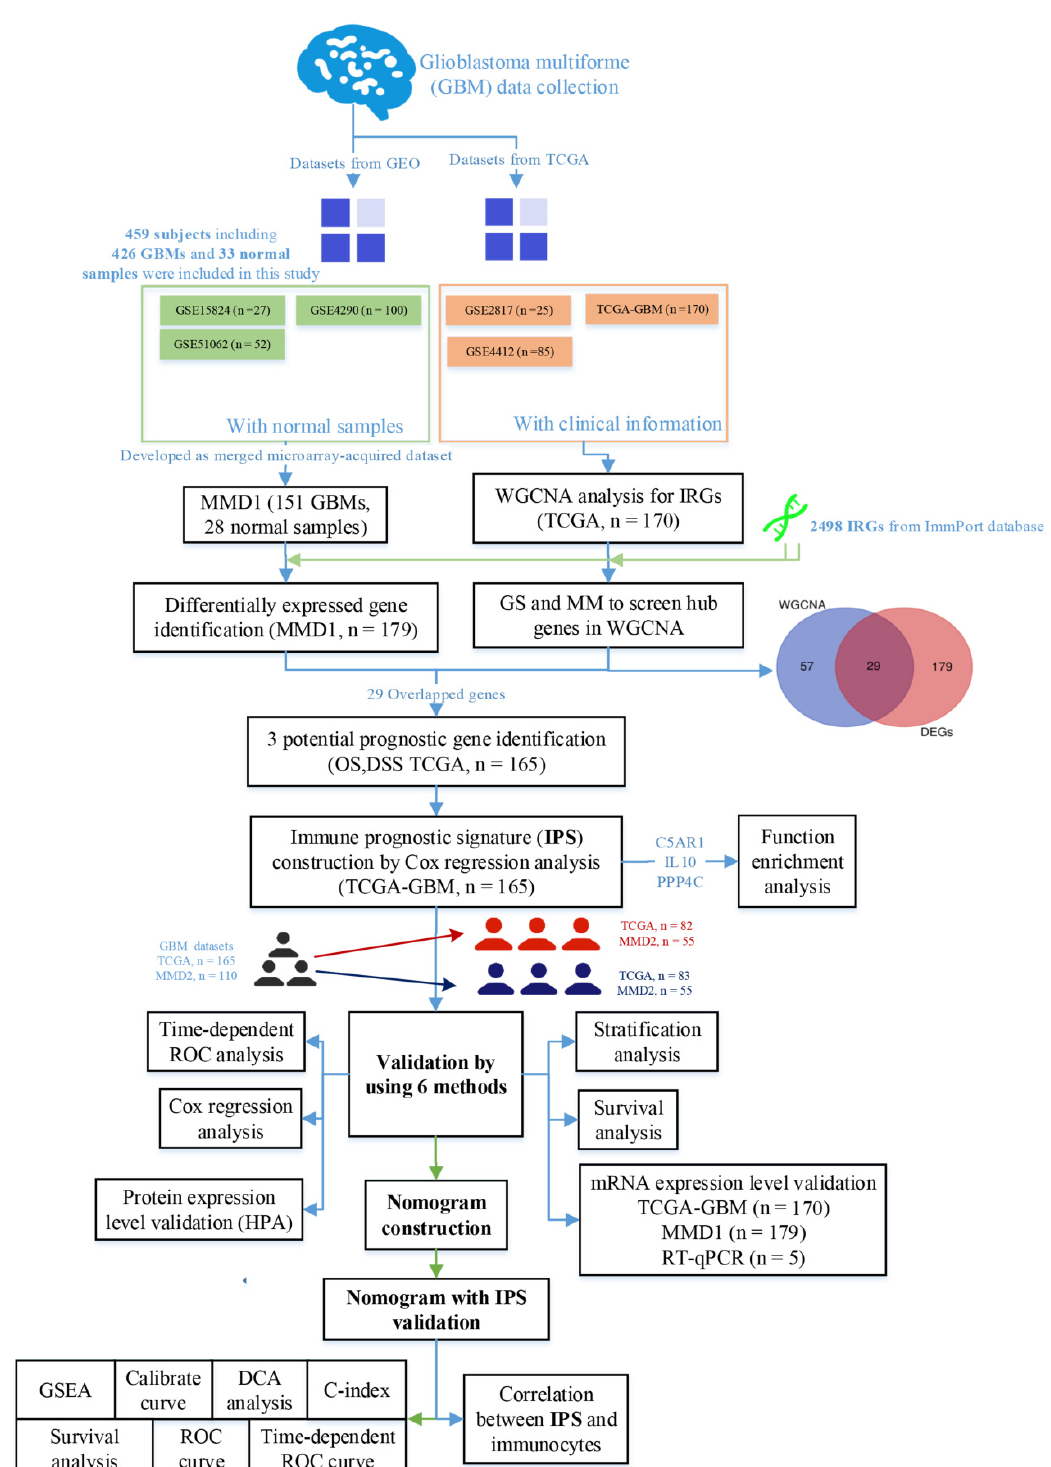
Figure 1. Flow diagram of this study demonstrating preparation, processing, and validation of